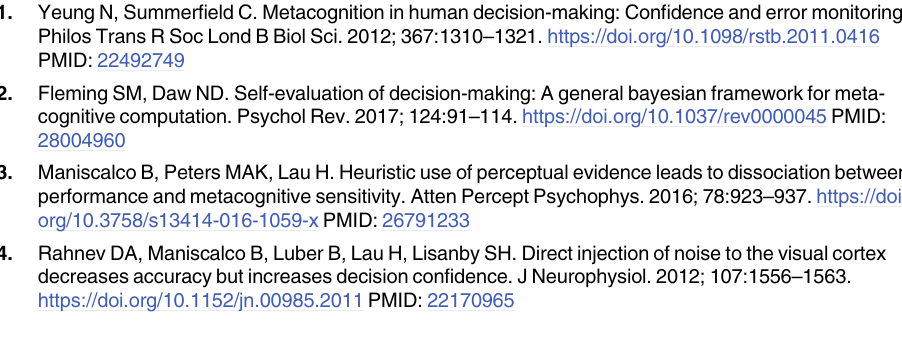
S7 Fig. Cortical projections of TMS sites. Single subjects’ coordinates of stimulation site for ( a) V5/MT+ (red) and V1/V2 (black) and ( b) IPS/LIP (blue) and V1/V2 (black), projected on a rendered brain surface from geometrical and EEG scalp positions reconstructed using MRI- Cro (https://www.nitrc.org/projects/mricro). S1 File. Supporting results and methods. Text A. Additional analysis on behavioral measure relative to first-order performance. Text B. Additional analysis on second-order performance. Text C. Supplementary discussion. Text D. Supplementary methods. Table A. Mean values ± SEM for hit rate (%), false alarm rate (%), criterion, and reaction times (ms) at each session, separately for condition. Table B. Mean R2 and slope ± SEM for each session, sepa- rately for